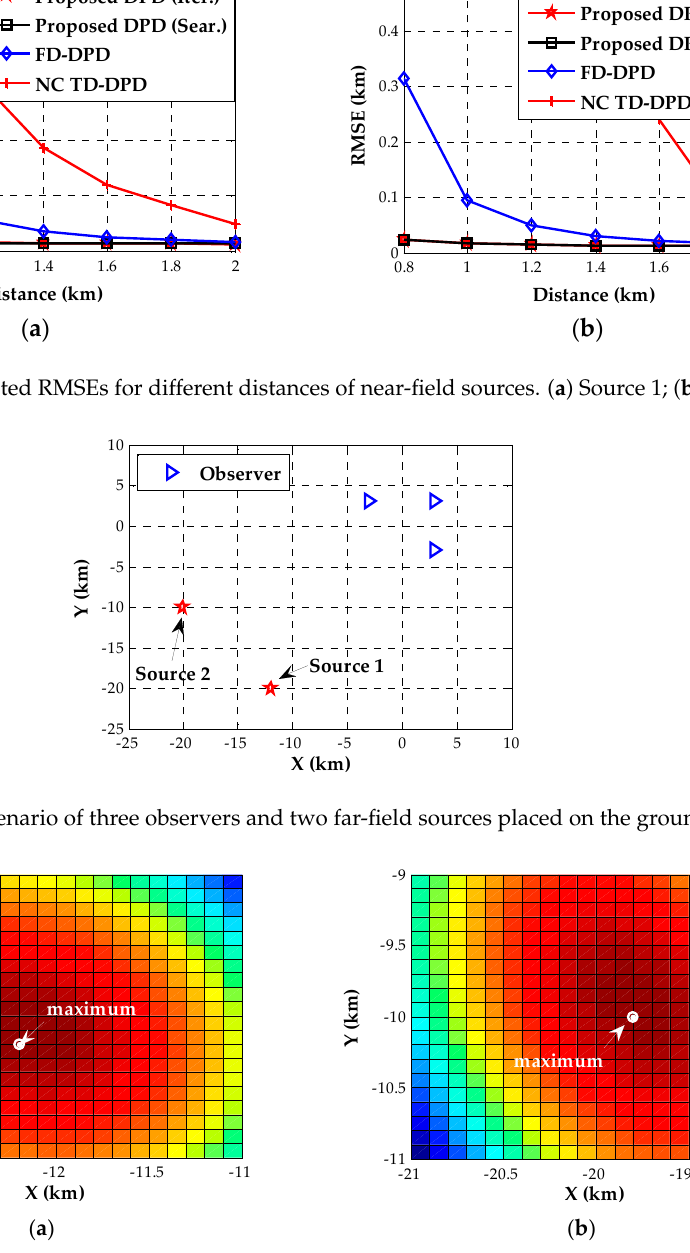
Figure 8. Evaluation of the inverse cost function over the area around the true positions of far-field sources, where different colors represent different magnitudes of amplitude. ( a ) Source 1; ( b ) Source 2.